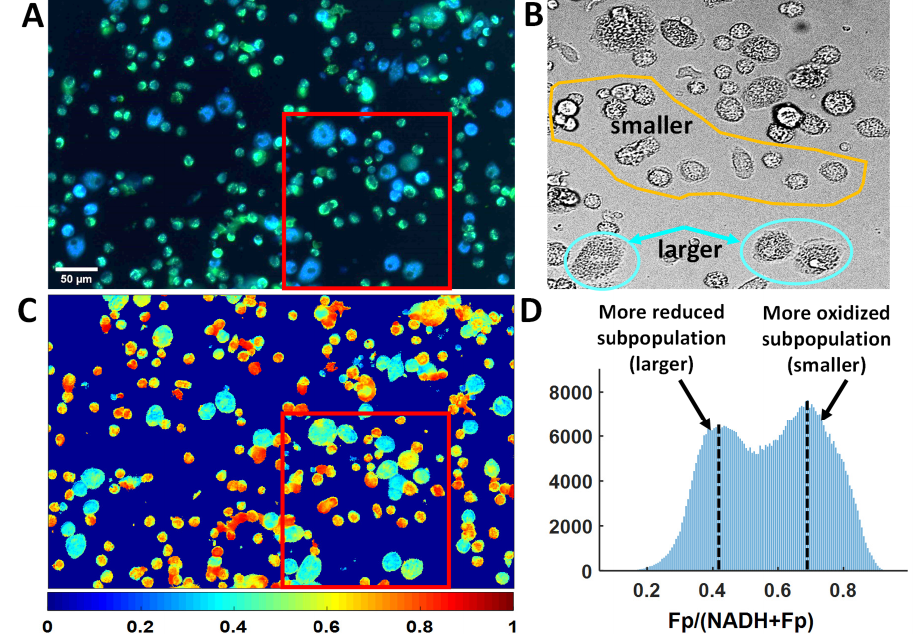
Figure 9. ORI detects AM redox heterogeneity within a male KO mouse with prior ozone exposure. ( A ) A representative composite image of NADH (blue) and Fp (green); ( B ) The white light image of an enlarged area outlined by the red frames in (A) and (C), with some larger and smaller cells encircled in cyan and yellow, respectively; ( C ) The redox ratio image corresponding to the image in (A), displaying two distinct redox subpopulations readily discerned by their pseudo-colors, i.e., cyan (more reduced state, redox ratio ~0.4) vs yellow-orange (more oxidized state, redox ratio ~0.7). The color bar indicates the redox ratio ranging from 0 to 1; ( D ) The histogram of the redox ratios from the image in (C), clearly shows a bimodal redox state, representing the mixture of a more reduced subpopulation and more oxidized subpopulation, respectively. The x-axis represents the redox ratio (Fp/(NADH+Fp)); y-axis represents the number of pixels having a specific redox ratio; dotted line represents the redox ratio of each subpopulation.